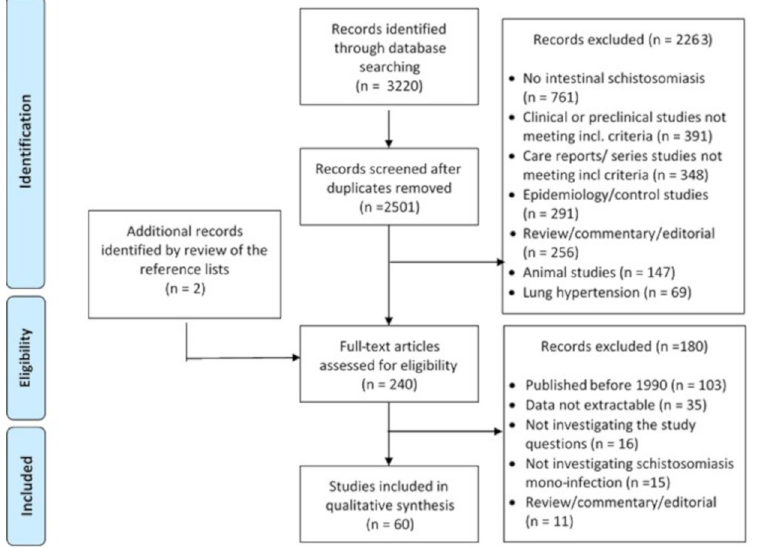
Fig 2. Literature search and selection of included